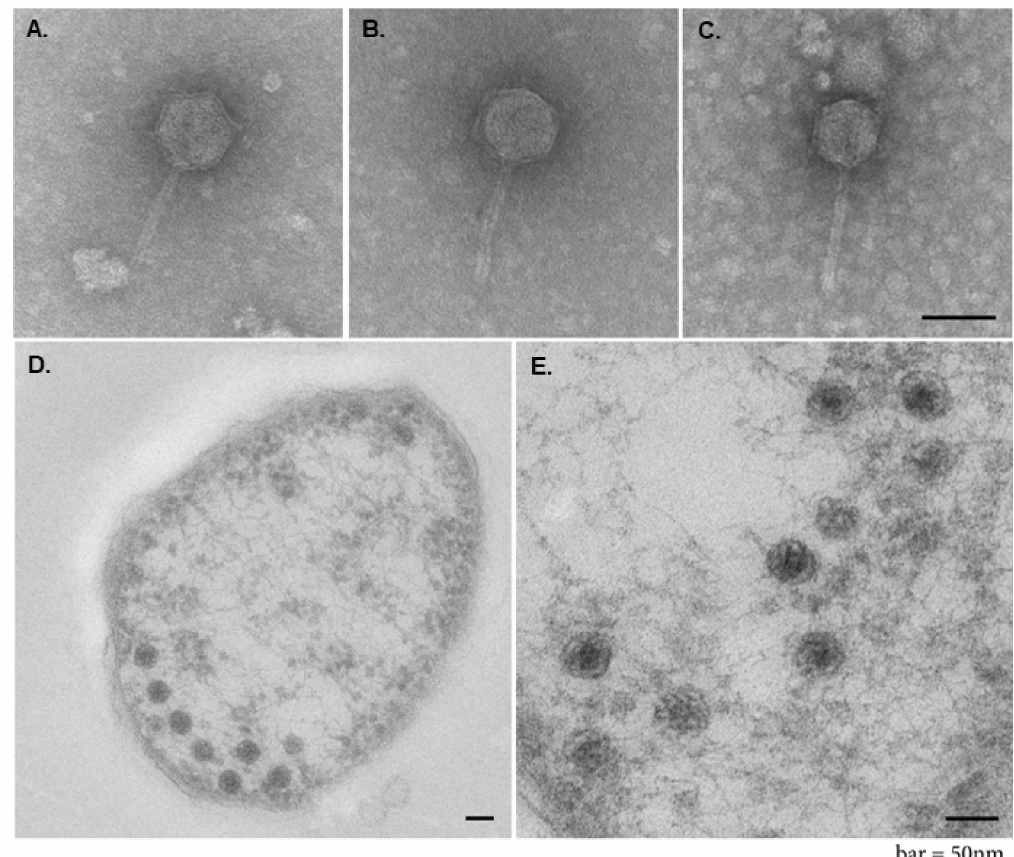
Figure 5. Electron micrographs of Francisella phage vB_ FhiM _KIRK. ( A – C ): Transmission EM of purified KIRK samples (see Section 2.5) stained with uranyl acetate. Phage particles are composed of an icosahedral head ~52 nm in diameter and a tail structure of ~82 nm in length and ~9 nm in width. ( D , E ): Thin section EM of UV treated Fhi 3523 cells, showing multiple phage particles inside of one bacterial cell. Bars = 50